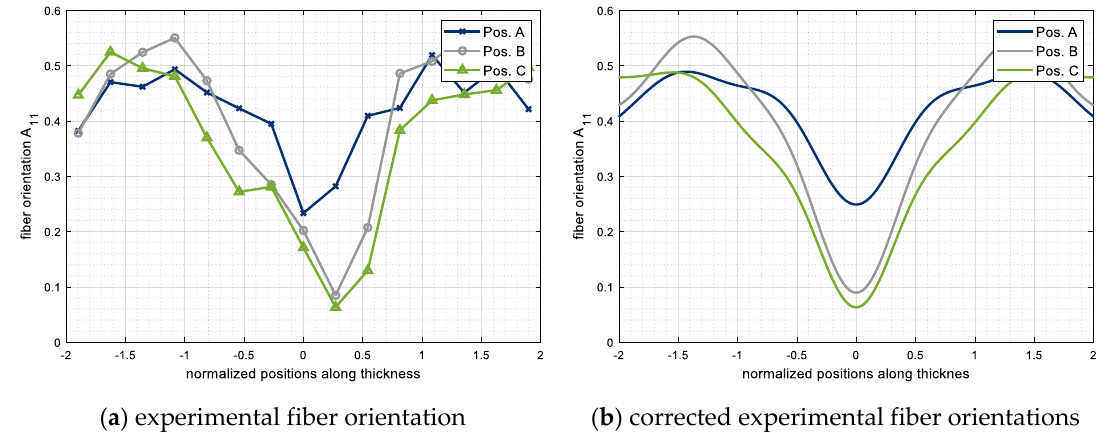
Figure 17. Experimentally determined fiber orientations along the flow path for PP-LGF20 v30.